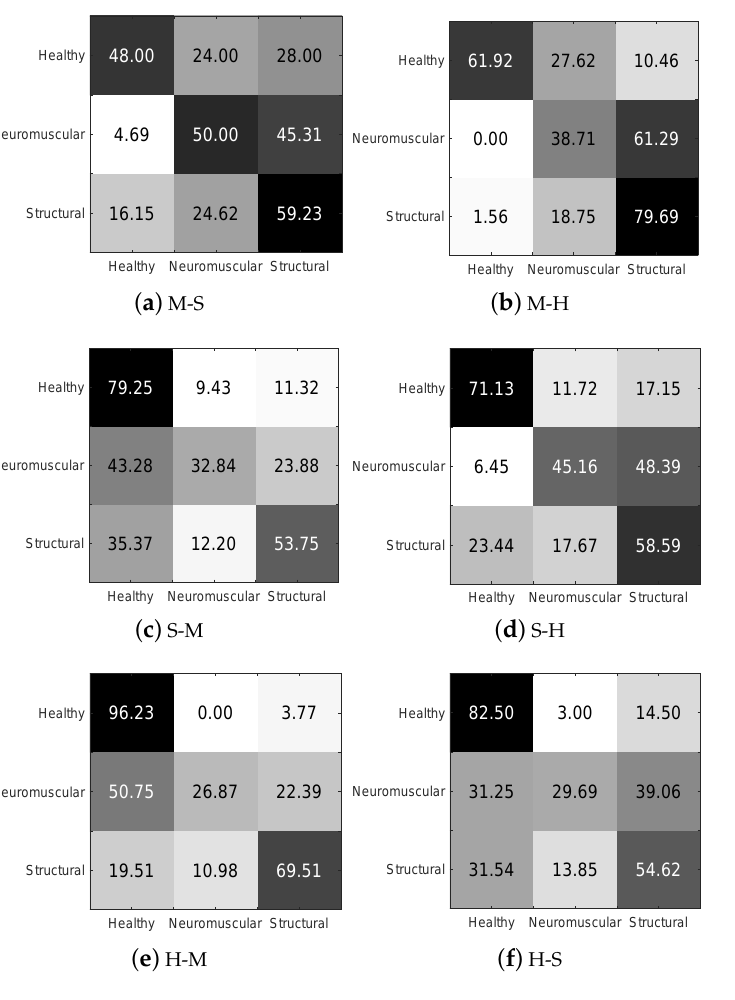
Figure 3. Confusion matrices of the proposed method under the six